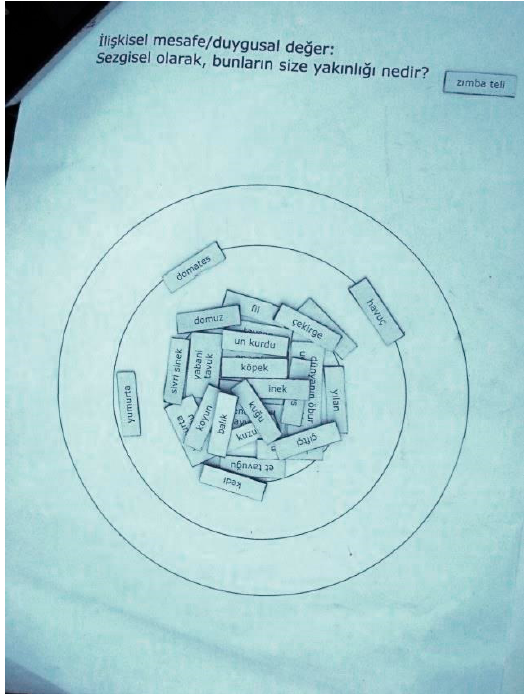
Figure 2. Circles of a respondent (Turkey, male, 15–30, urban) assigning equal importance to humans and other animals (the only cards positioned in the outer circles were tomato , carrot , and egg ).